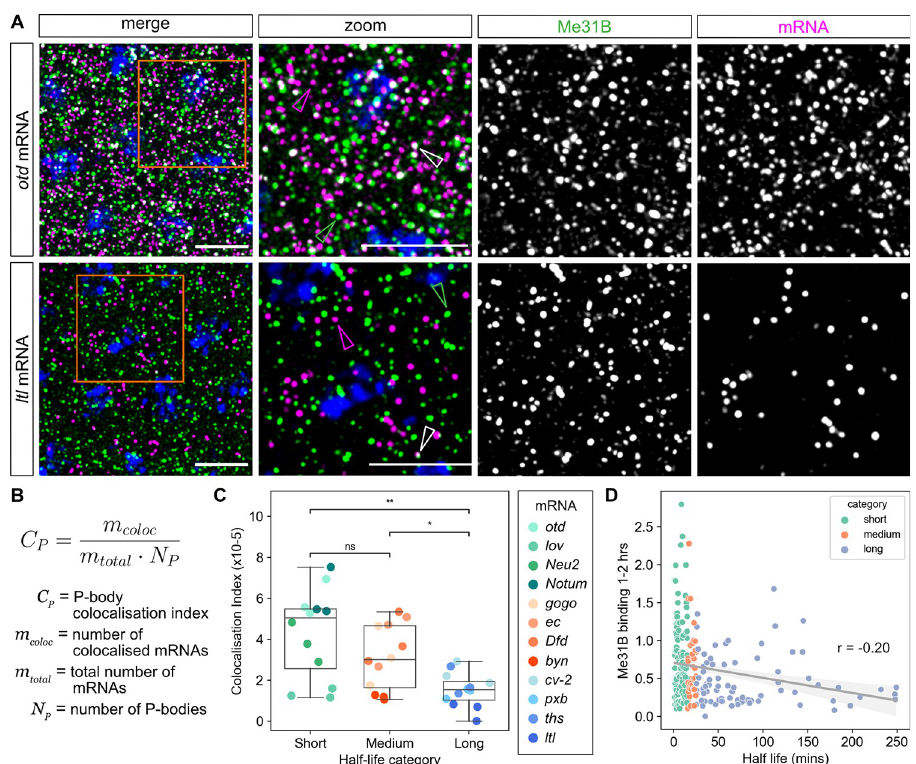
Fig 5. Short half-life mRNAs are more colocalised with P-bodies in the early embryo. (A) Confocal images of fixed, early nc14 embryos stained with smFISH probes for the indicated mRNAs (magenta) and labelled GFP-Me31B P- bodies (green). Scale bars: 5 μ m. Images are maximum projections of 7 slices, with higher magnification images of the highlighted regions (orange box) shown. Individual mRNAs (magenta arrowheads), P-bodies (green arrowheads), and colocalised mRNA and P-body signals (white arrowheads) are highlighted. (B) The P-body colocalisation index used to calculate the normalised proportion of colocalised mRNAs, facilitating comparison between different mRNAs. (C) Graph of the P-body colocalisation index for the indicated mRNAs in early nc14. mRNAs are grouped by half-life category, within which they are coloured by half-life as per Fig 4F with points representing individual embryos. Both short and medium half-life mRNAs are significantly more colocalised with P-bodies than long half-life mRNAs ( p = 1.257 × 10 − 3 and p = 1.640 × 10 − 2 , respectively). Short half-life mRNAs are not significantly more enriched in P- bodies than medium half-life mRNAs ( p = 4.168 × 10 − 1 ). (D) Half-life versus Me31B binding data from 1–2-hour embryos [52] (Pearson’s r = − 0.20, p = 1.5 × 10 − 3 ). Underlying data can be found in S1 Data. smFISH, single-molecule fluorescent in situ